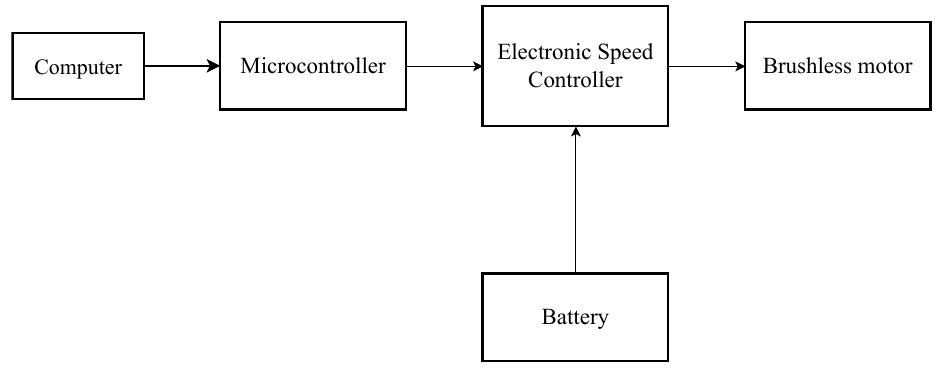
Figure 2. Motor assembly and